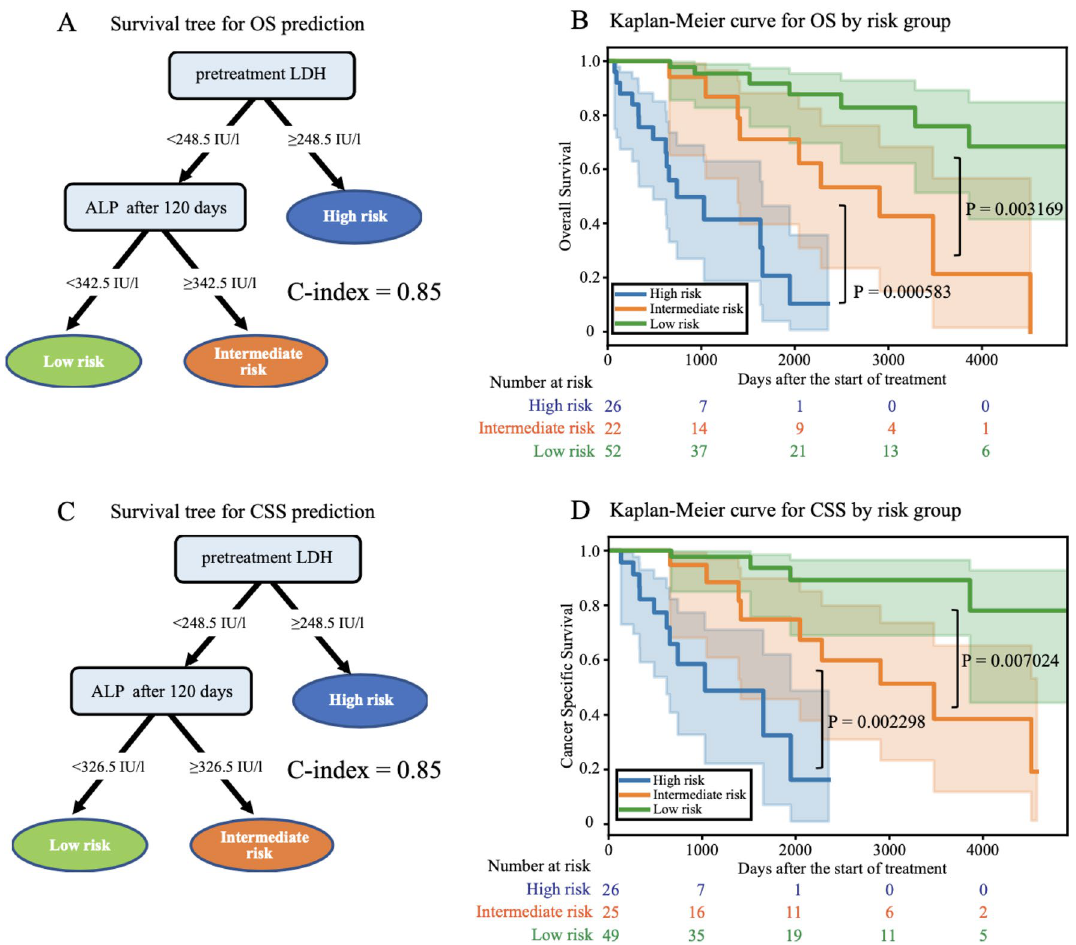
Figure 3. Survival tree predicting overall survival ( A ) and cancer-specific survival ( C ). Kaplan–Meier curves of survival tree prognostic classification results for overall survival prediction ( B ) and cancer-specific survival prediction ( D ). P-values were calculated by the log-rank